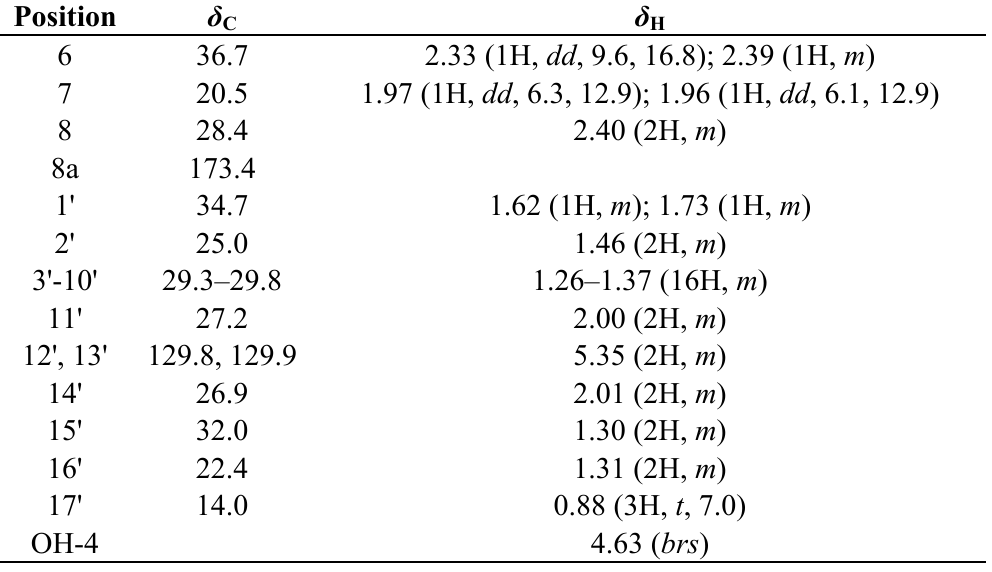
Figure 2. MS fragmentation of 1 .